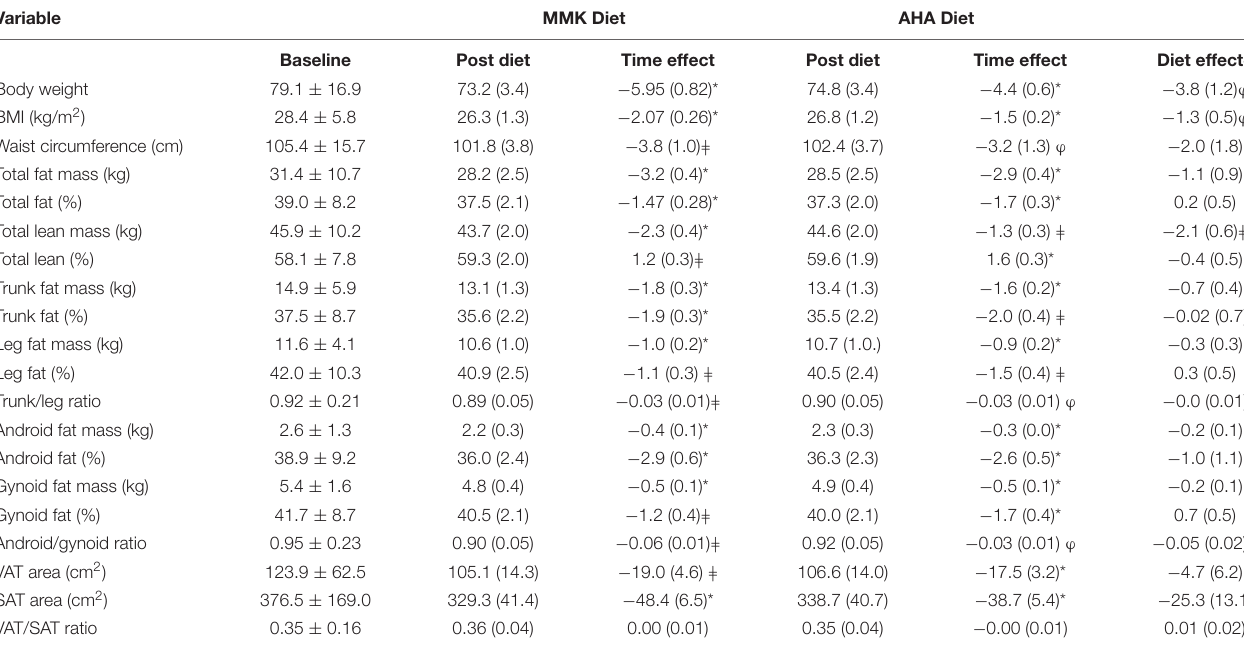
TABLE 2 | Effect of MMK and AHA diets on body weight, body composition and body fat distribution.